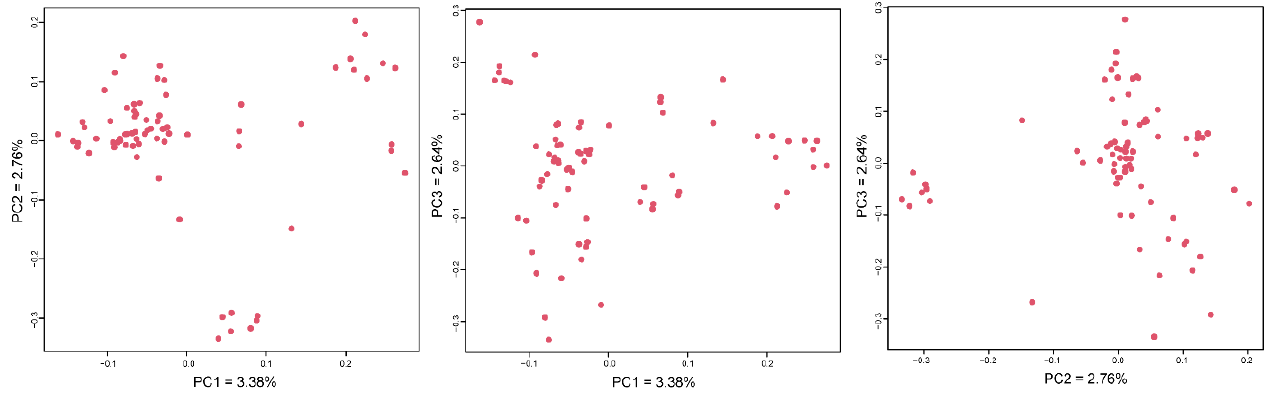
Table 1. Single nucleotide polymorphism chip marker-based quality filtering results.